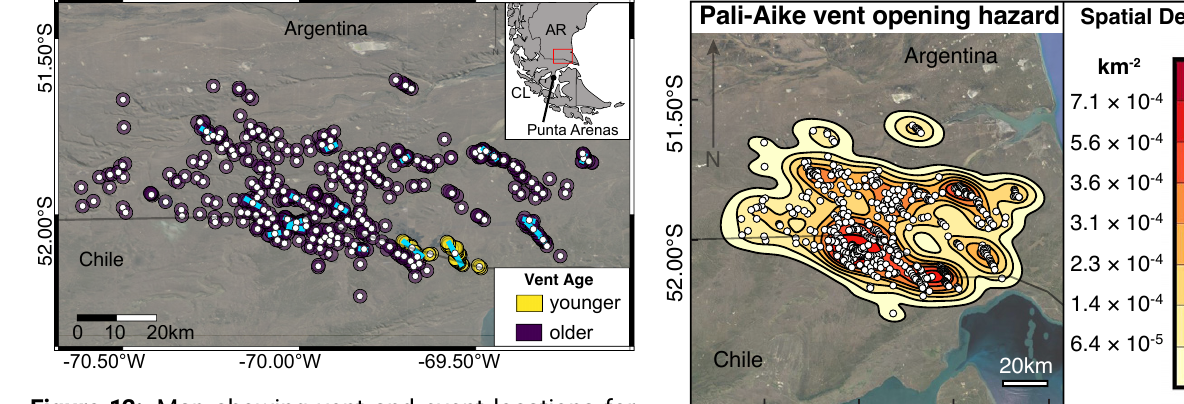
Figure 12: Map showing vent and event locations for Pali-Aike volcanic field, Argentina-Chile Border [modi- fied from D’Orazio et al. 2000]. The purple dots indicate the U2 aged vents and the yellow U3 aged vents (as de- scribed in D’Orazio et al. [2000]), while the white dots show the location of calculated events. The blue lines show the alignment of linear clusters defined by the event modelling code. Map background data: Google, CNES/Airbus, Maxar Technologies.